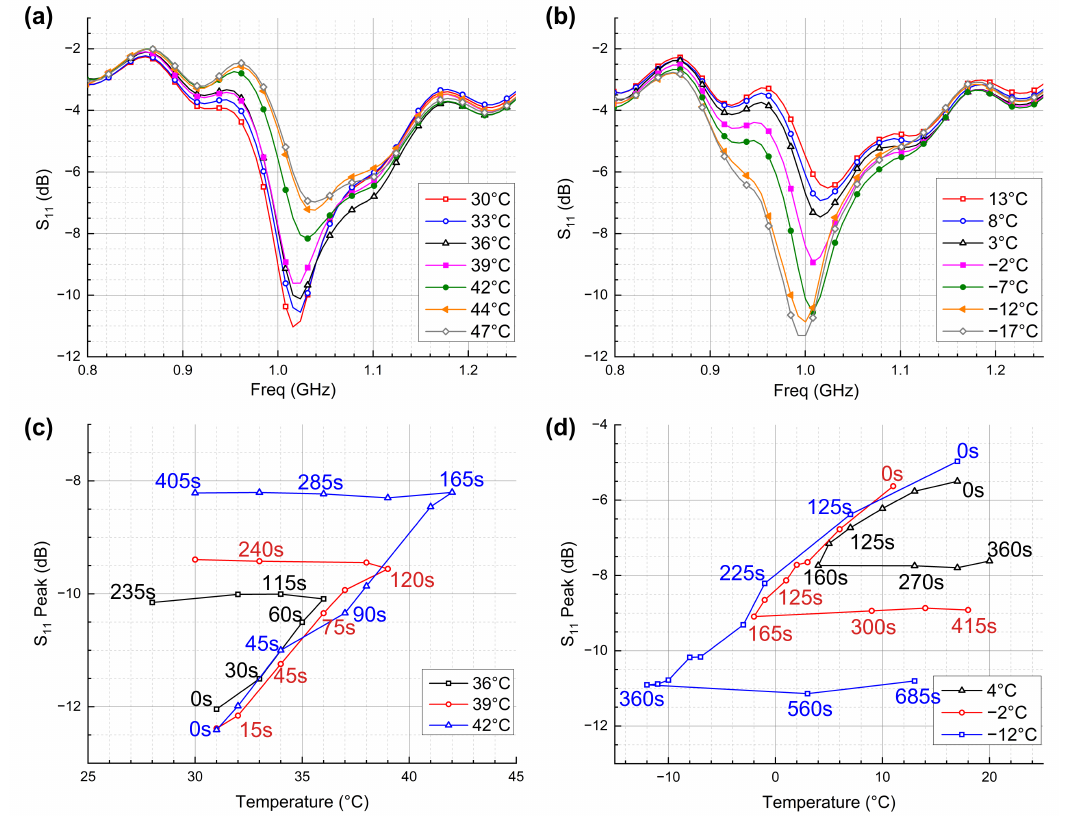
Figure 6. Return loss S 11 of two-way SMA under ( a ) heating and ( b ) cooling process; and peak value of S 11 when two-way SMA are ( c ) heated and ( d ) cooled to different